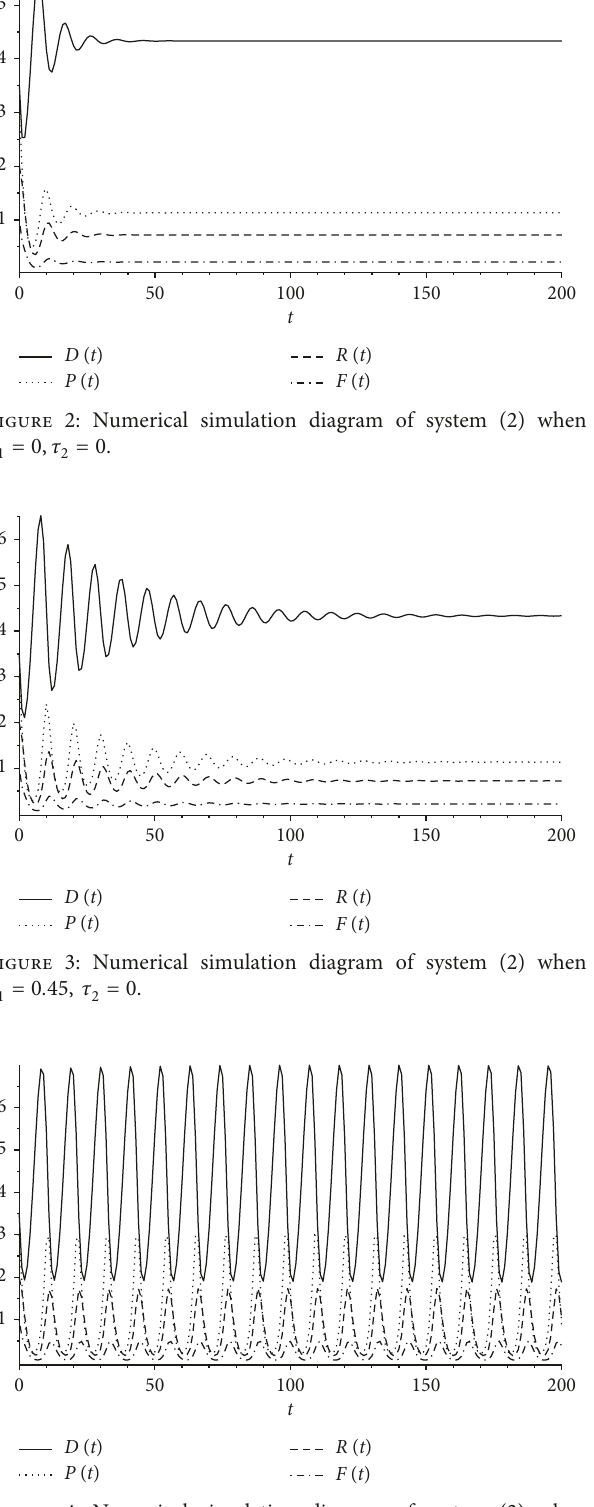
Figure 4: Numerical simulation diagram of system (2) when � 0 . 65 , τ � 0. τ 1 2